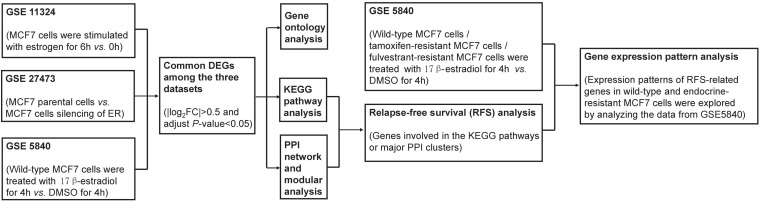
The diagram of the workflow and datasets.